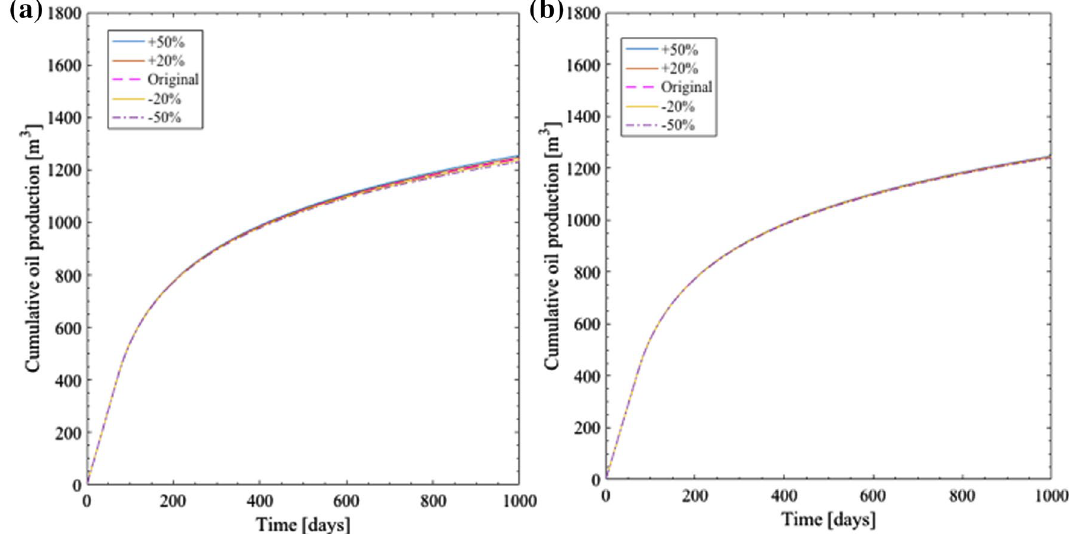
Fig. 7 Variation of cumulative oil production with a relative electro-osmotic permeability of water ( k osmotic permeability of water–oil ( k er,wo )